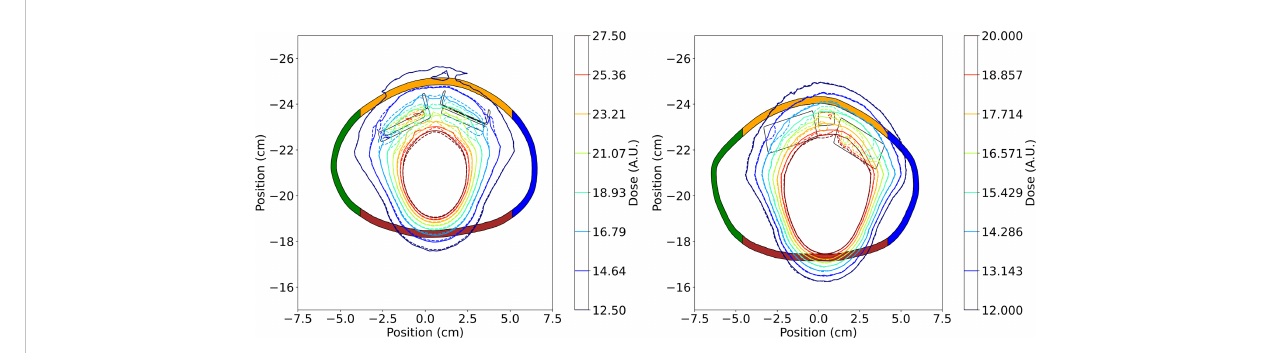
FIGURE 7 Axial isodose distributions in arbitrary units (A.U.) calculated with Monte Carlo for the AlloX2 (left) and AlloX2-Pro (right) TTEs. Solid lines correspond to RS1, and dashed lines correspond to RS2. The colored regions correspond to each contour shown in Table 2. The outer limiting frame of the metal ports are shown with solid lines.